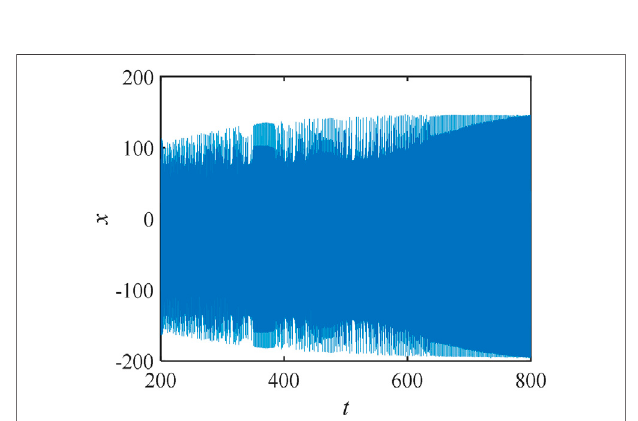
FIGURE 9 | Complexity of the system. (A) SE complexity; (B) C0 complexity.